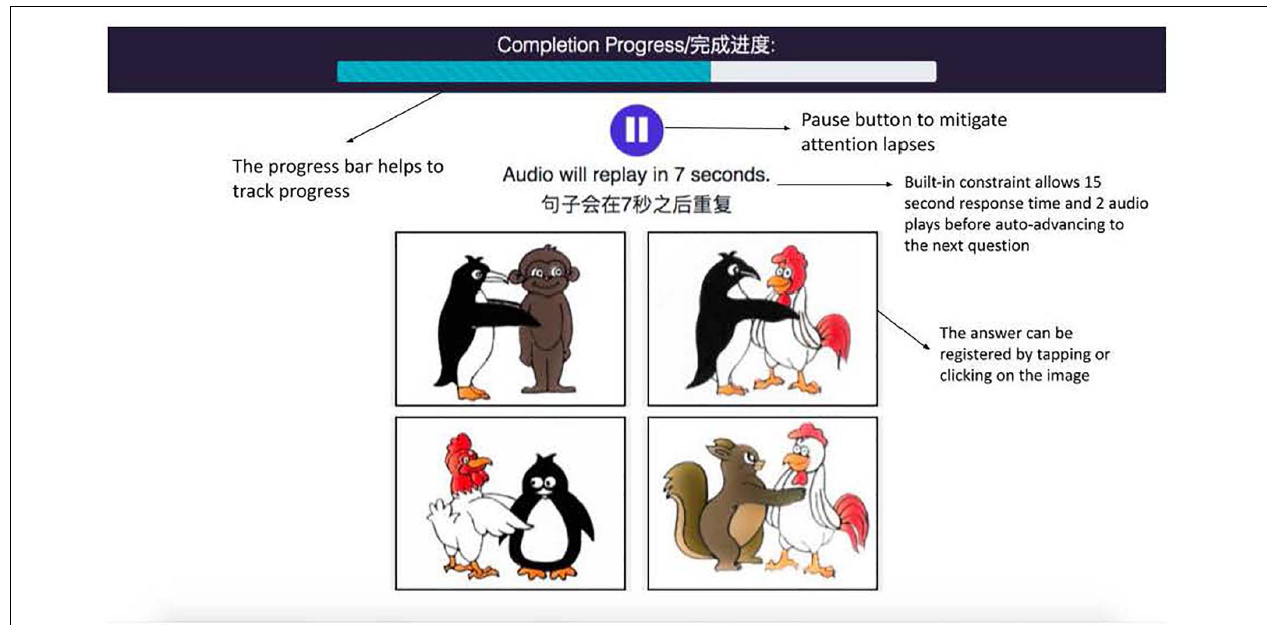
FIGURE 1 | Illustration of a test item from the MECOLAB interface. The child hears the audio “the monkey is hugged by the penguin.”